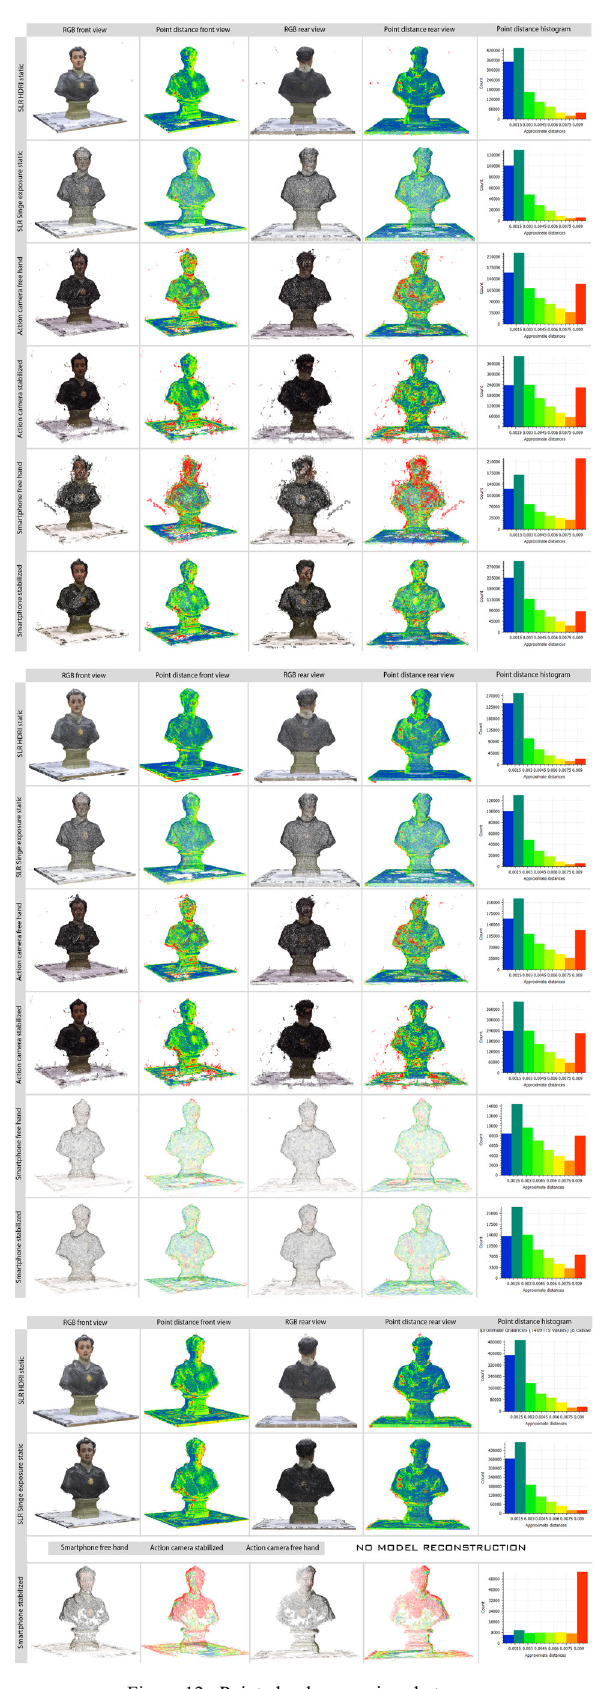
Figure 12. Point cloud comparison between photogrammetric model and 3D laser scanning reference (processed by Agisoft Metashape, 3DFlow Zephyr, Pix4D Mapper